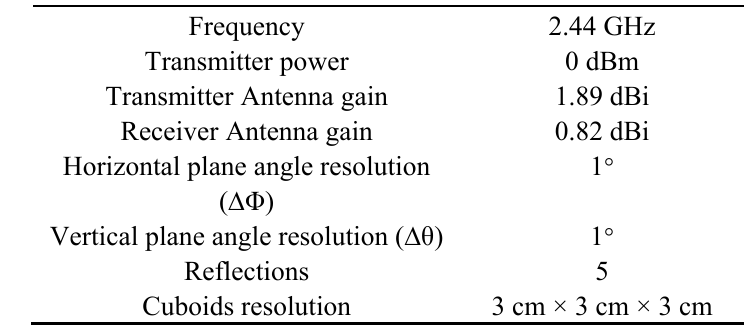
Table 2. Parameters considered for the deterministic technique of ray launching.